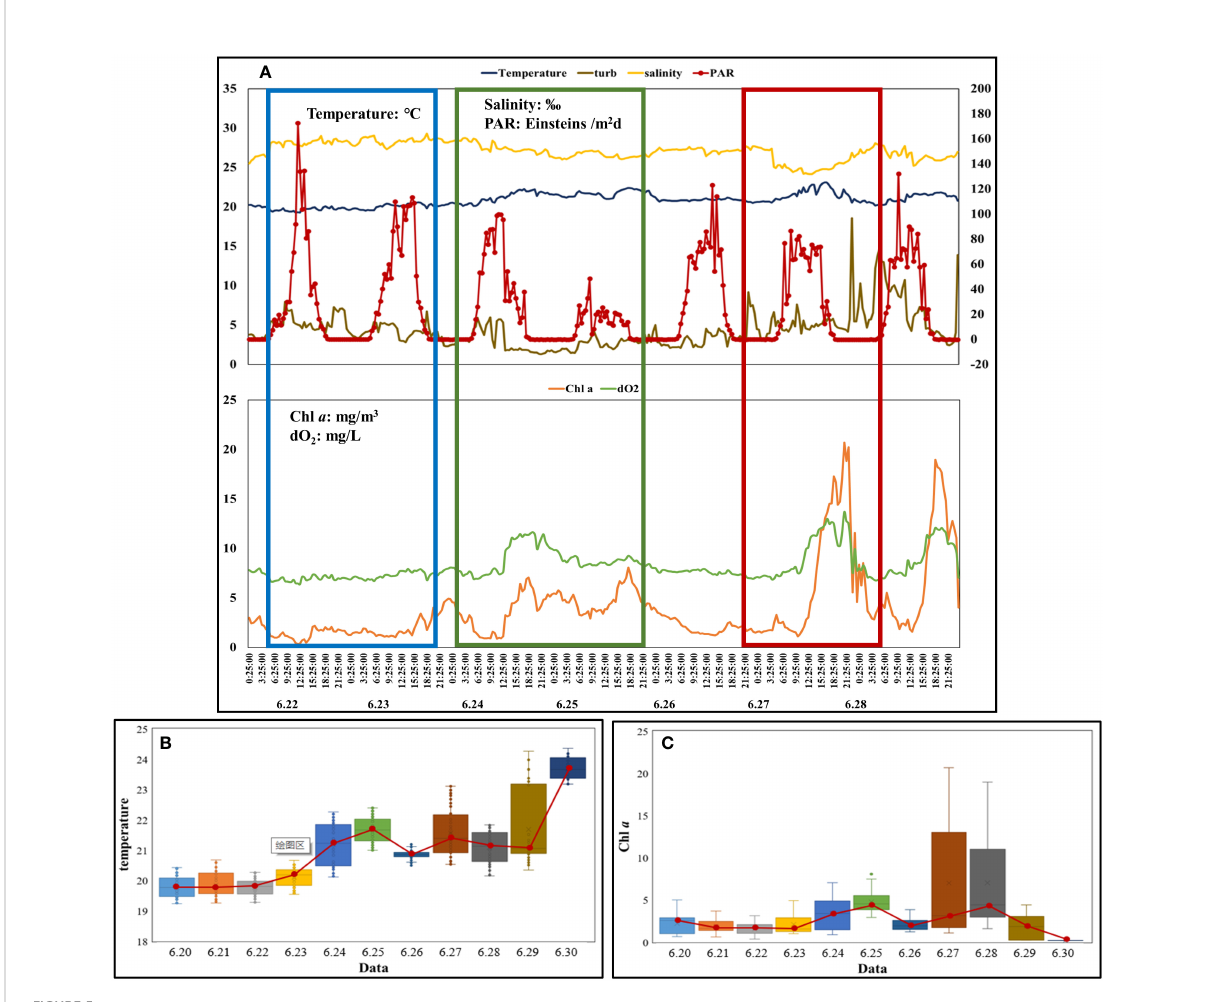
FIGURE 5 The variations of parameters measured by buoy during typhoon “ Meari ” . The variations when the typhoon passes are marked with red box. The typhoon passed through the Yangtze Estuary on June 25. The red, green and blue boxes represent several typical situations analyzed in the paper. (A) show the daily changes before, during, and after the typhoon, (B, C) show the Chl a and temperature changes with box plots,